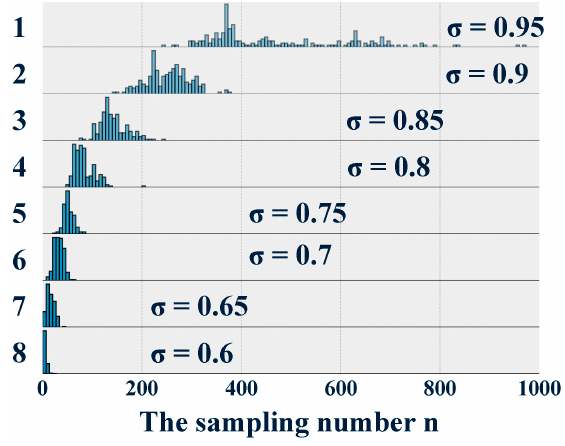
Figure 3. The overlapping densities plot of group A. Table 3. The statistics for the designed diagnostic system in group A.